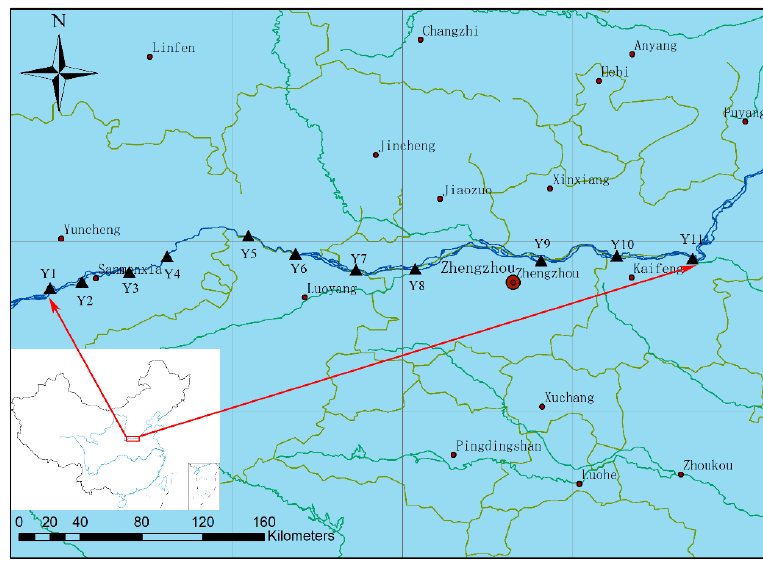
Figure 1. Sample sites in the Henan section of the Yellow River.